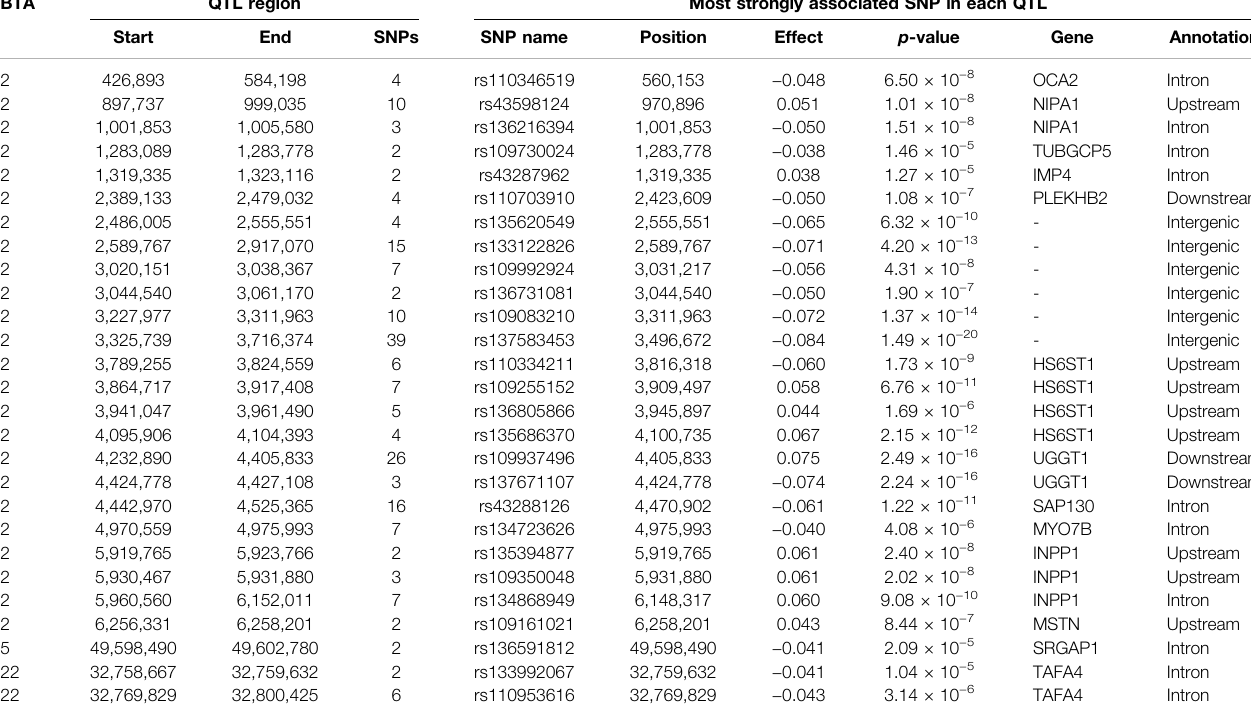
TABLE 5| Chromosome(BTA),startand endposition(bp),andthenumberofsigni fi cantand suggestivesingle nucleotide polymorphisms(SNPs)withintheimprintedQTLs associated with carcass fat, and the SNP name, position, imprinting effect, p -value, nearest gene within 0.5 Mb and annotation of the lead SNP. BTA QTL region Most strongly associated SNP in each QTL